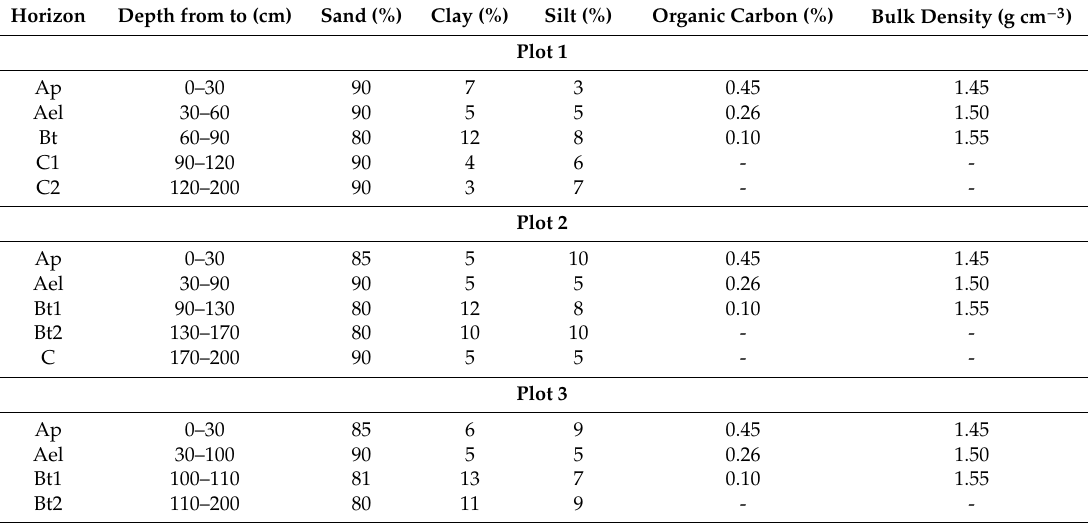
Table 1. Soil physical parameters, horizon classification according to [34].